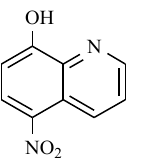
Figure 11. The chemical structure of nitroxoline.